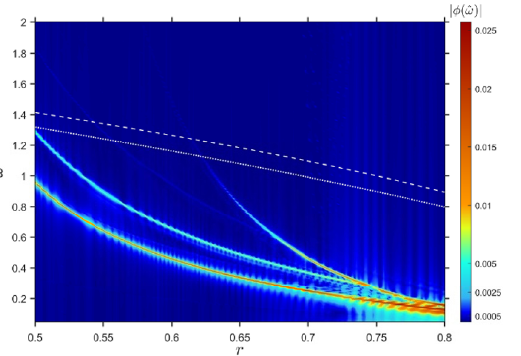
Figure 13 . Large kink-antikink collision: Fourier transform at the center of the thinnest antikink- kink pair. For all points we fixed v = 0 . 25. The white dashed line corresponds to frequencies in continuum mode. The white dotted line corresponds to the vibrational